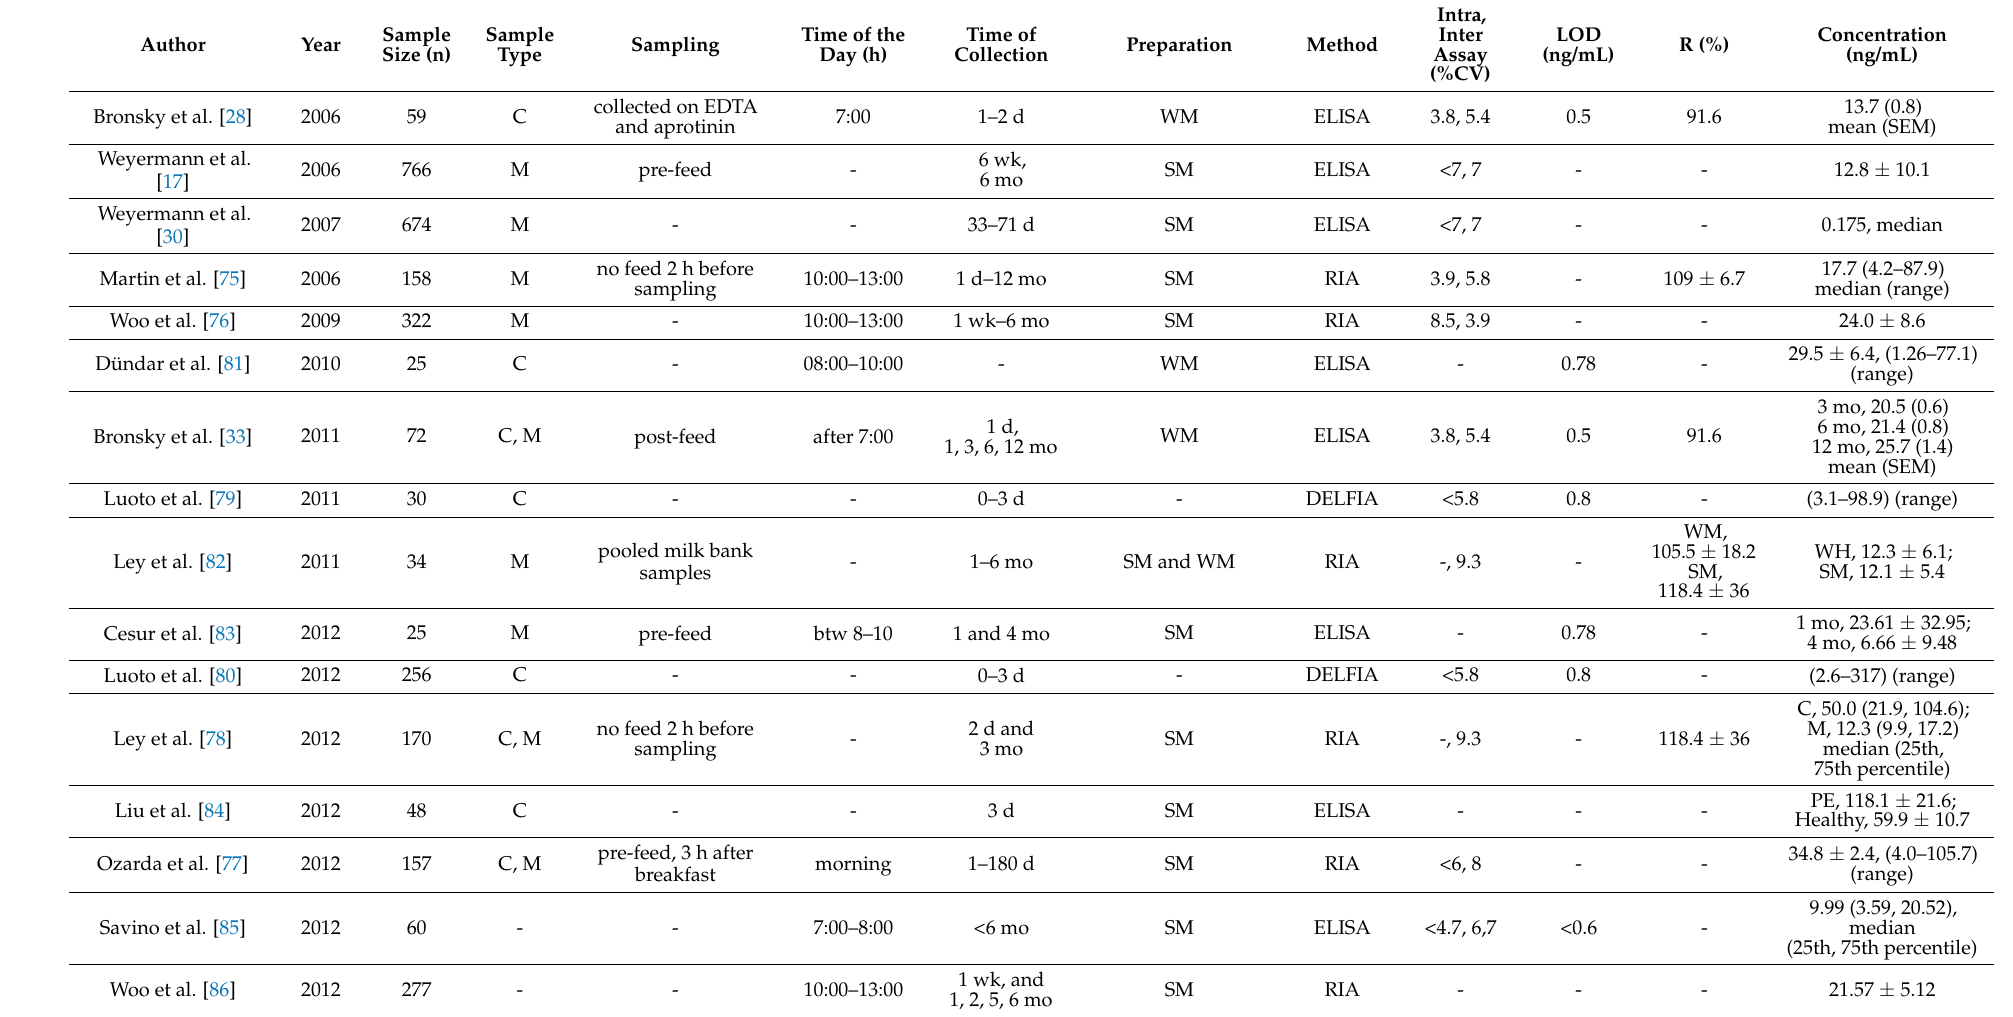
Table 2. Studies examining human milk